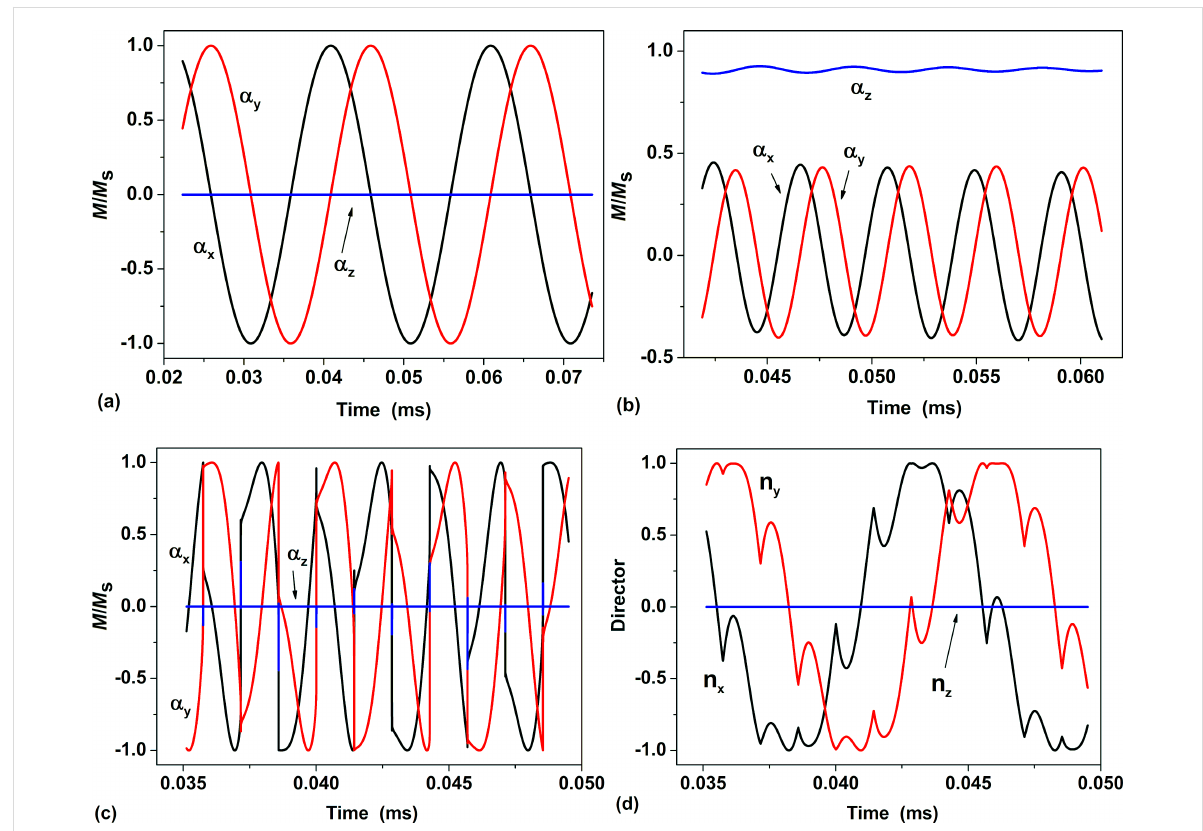
Figure 1: Dynamics of the unit magnetization vector in RMFs in the magneto-dynamics approximation for various regimes of stationary motion of a nanoparticle in a viscous liquid: a) first mode, f = 50 kHz, H 0 = 200 Oe; b) second mode, f = 240 kHz, H 0 = 100 Oe; c, d) particle dynamics in the third mode, f = 450 kHz, H 0 = 400